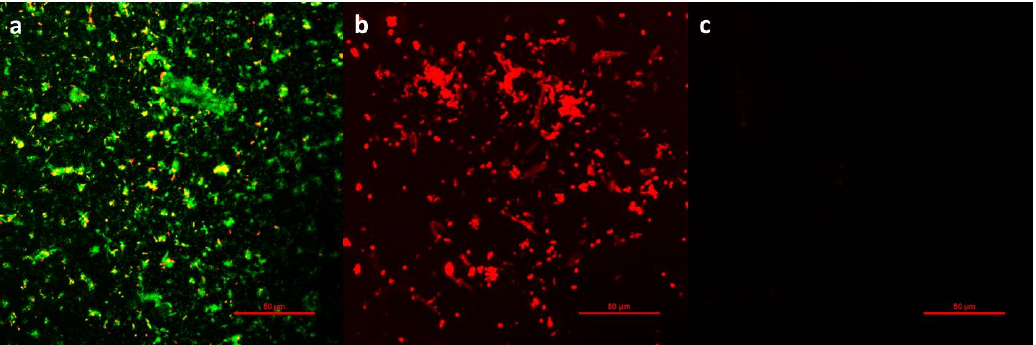
Figure 6. Confocal laser scanning microscopy (CLSM) images of E. coli adherent onto ( a ) PU, ( b ) PU-PHMG, and ( c ) PU-(PHMG/HA) 5 /5-5 film. The live bacteria appear as green fluorescence and dead bacteria appear as red fluorescence. Scale bars are 50 μ m.